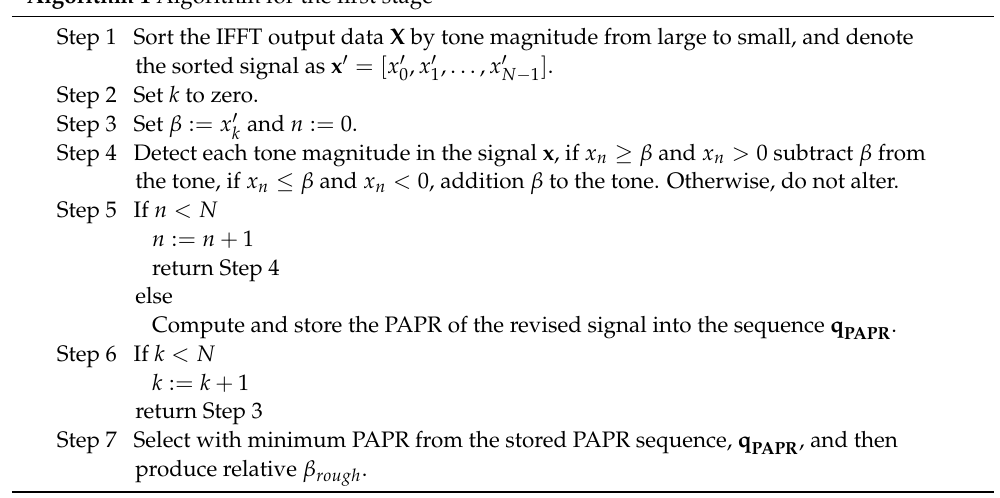
Algorithm 1 Algorithm for the first